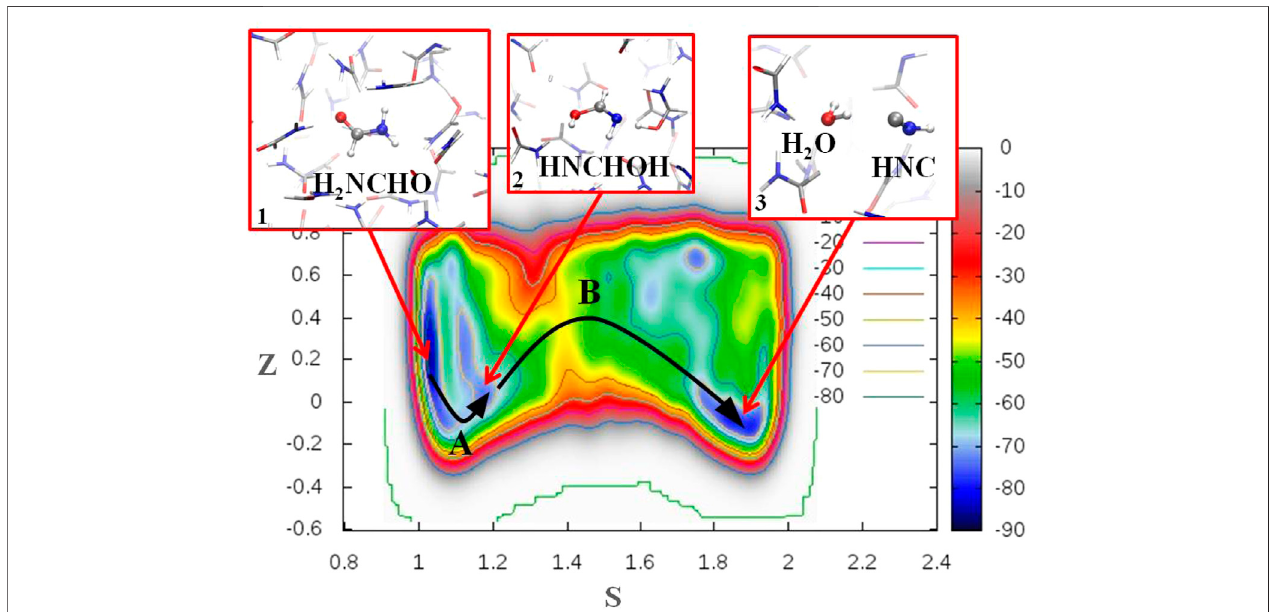
FIGURE 4 | Free-energy surface of the dehydration reaction of formamide in liquid formamide at 160 ° C and in absence of any catalyst obtained via ab initio moleculardynamicsandmetadynamicssimulations.Asschematicallyindicatedbytheinsets,valuesoftheCollectiveVariableS ≈ 1indicateamolecularstateclosetothe reactants whereas values of S ≈ 2 indicate atomistic arrangement close to the products state. Free energies are expressed in kcal · mol − 1 .